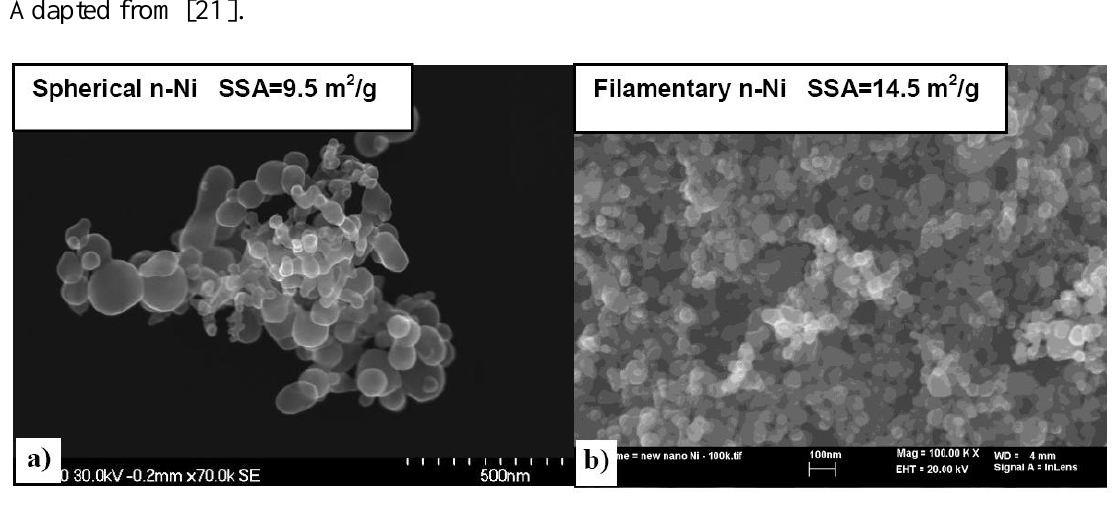
Figure 6. Scanning electron micrographs of the morphology of Vale Inco Ltd. nanometric Ni (n-Ni) with (a) SSA = 9.5 m 2 /g and (b) SSA = 14.5 m 2 /g used as a catalytic additive. Adapted from [21].